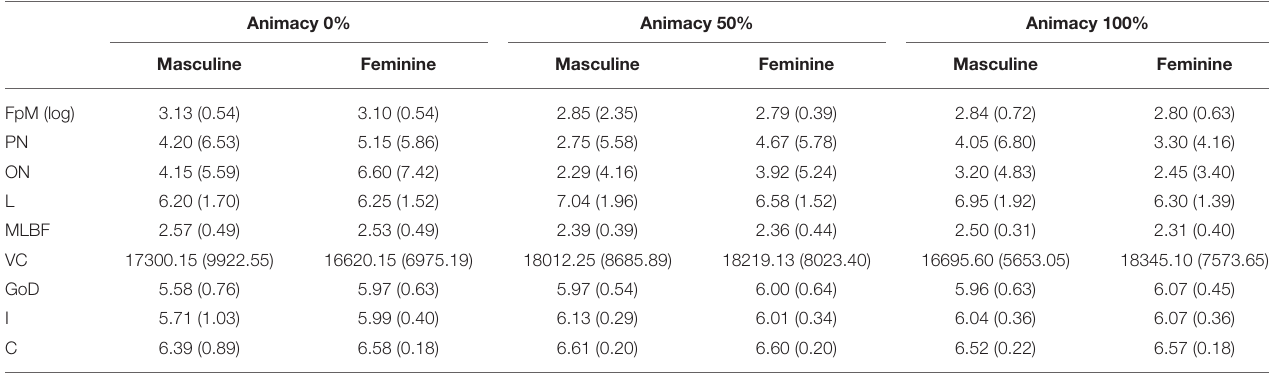
TABLE 2 | Mean and standard deviations (in parenthesis) of the controlled variables per Target type for all the experimental pictures in Experiment 1. Animacy 0% Animacy 50% Animacy